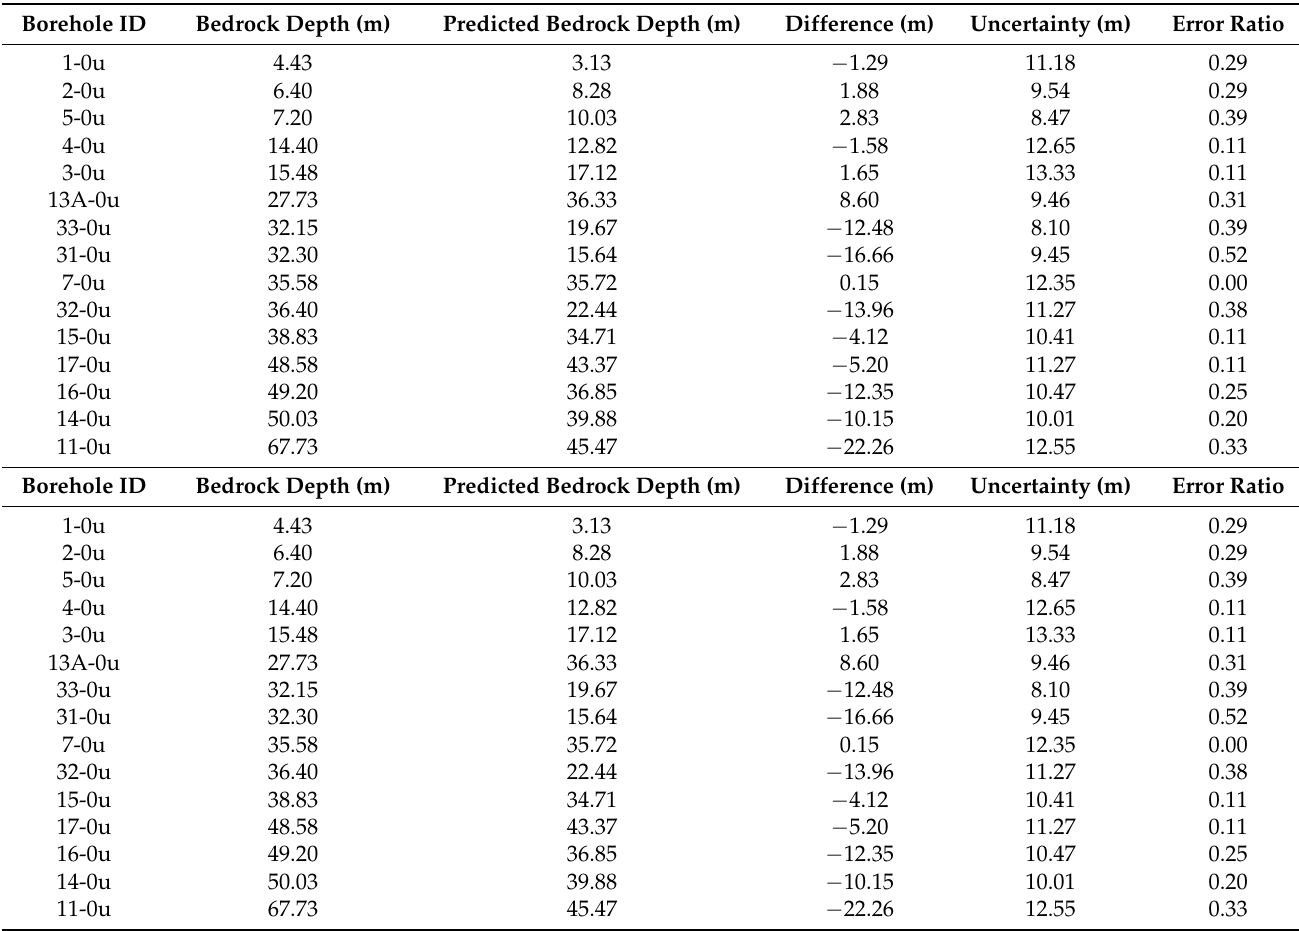
Table A2. An overview of the ground truthing dataset, showing the depth of confirmed bedrock, the predicted depth at this borehole location, the difference, the uncertainty of the prediction and the error